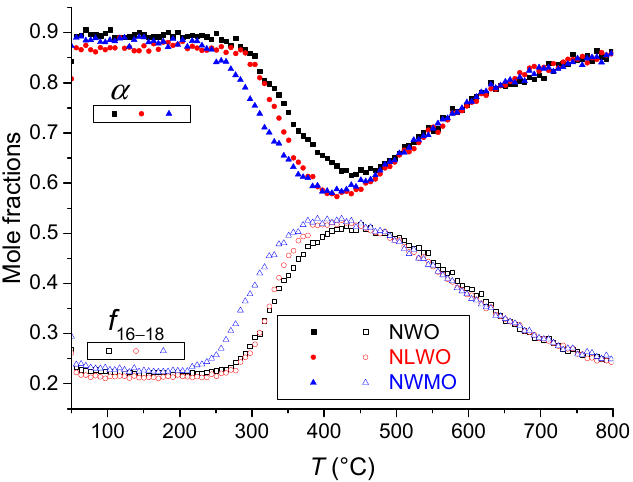
Figure 7. Temperature programmed isotope exchange of oxygen with C 18 O 2 in the flow reactor for samples synthesized by mechanical activation and sintered by e-beams at 1100 °C: NWO (black squares), NLWO (red circles) and NWMO (blue triangles).